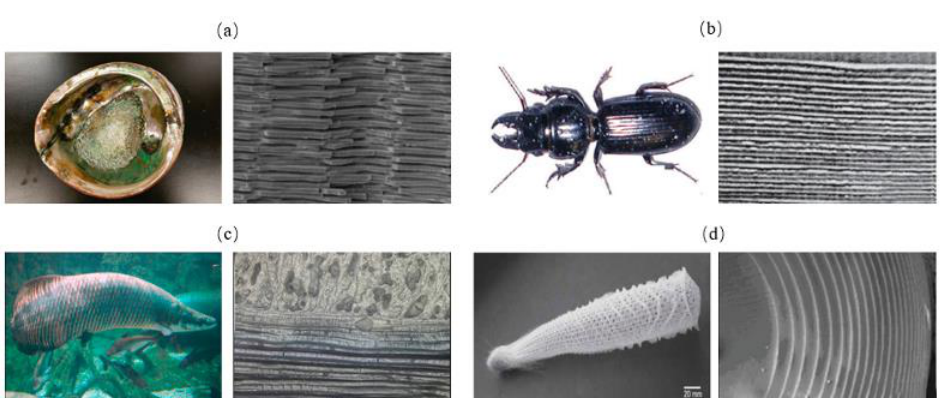
Figure 2. Layered model in biological organisms. ( a ) nacre shell [24] Copyright©2009, Progress in